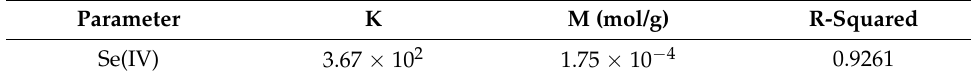
Table 3. Langmuir fitting parameters for sorption of Se on TMS clay.